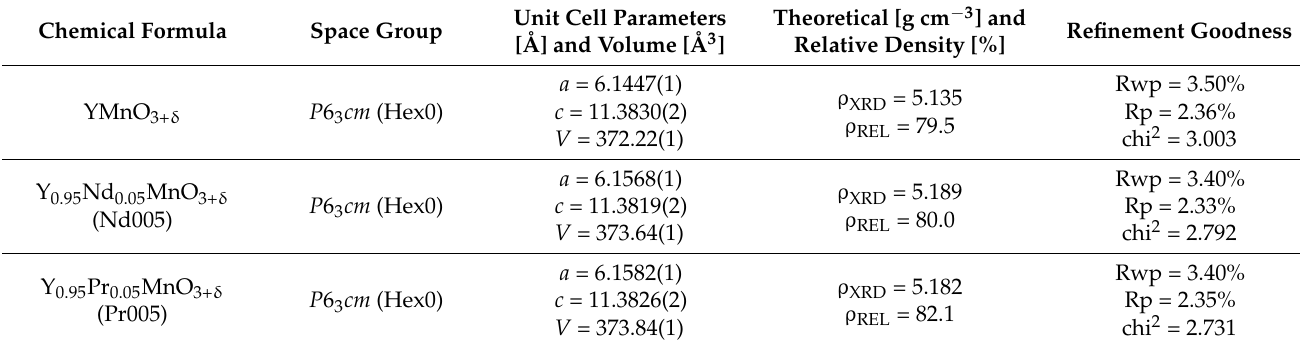
Figure 1. X-ray diffraction patterns of as-sintered pellets of YMnO 3+ δ , Nd005, and Pr005. Table 1. Results of Rietveld refinement of X-ray diffractometry (XRD) data for samples sintered at 1400 ◦ C for 3 h in air. Chemical